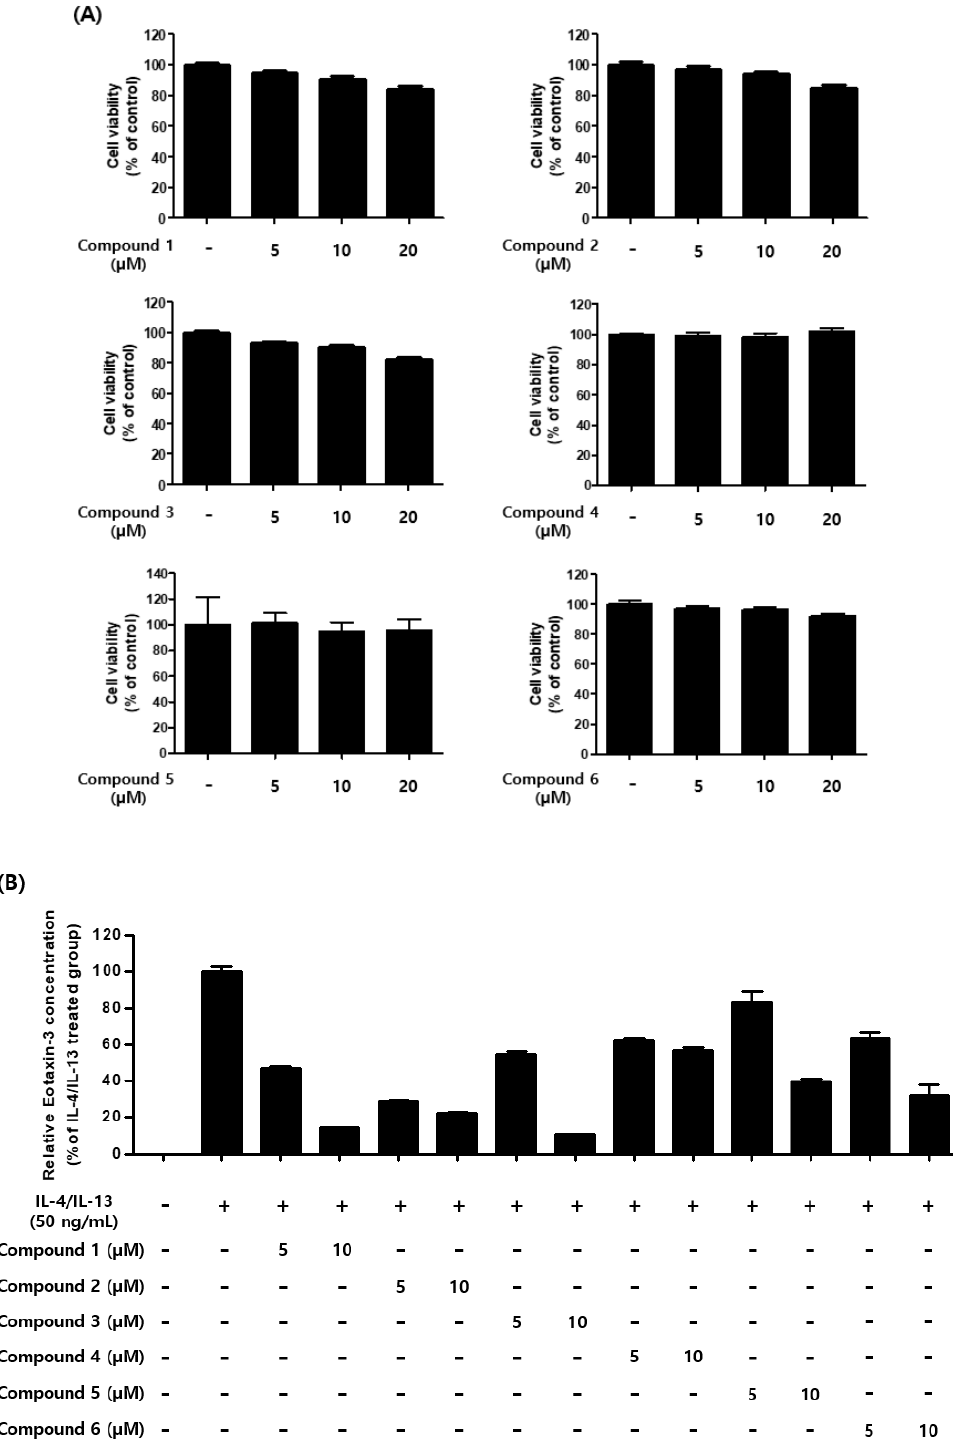
Figure 5. Effect of the isolated compounds 1 – 6 on IL ‐ 4/IL ‐ 13 ‐ induced AD ‐ like human keratinocytes (HaCaT cells). ( A ) Cell viability was measured after treatment of compounds 1 – 6 (0, 5, 10 and 20 μ M) for 48 h. ( B ) Cells were treated with compounds 1 – 6 and induced with IL ‐ 4/IL ‐ 13 (50 ng/mL each). The production of eotaxin ‐ 3 in culture supernatants was measured by ELISA ( n = 3). The data are expressed as the mean ± standard deviation.